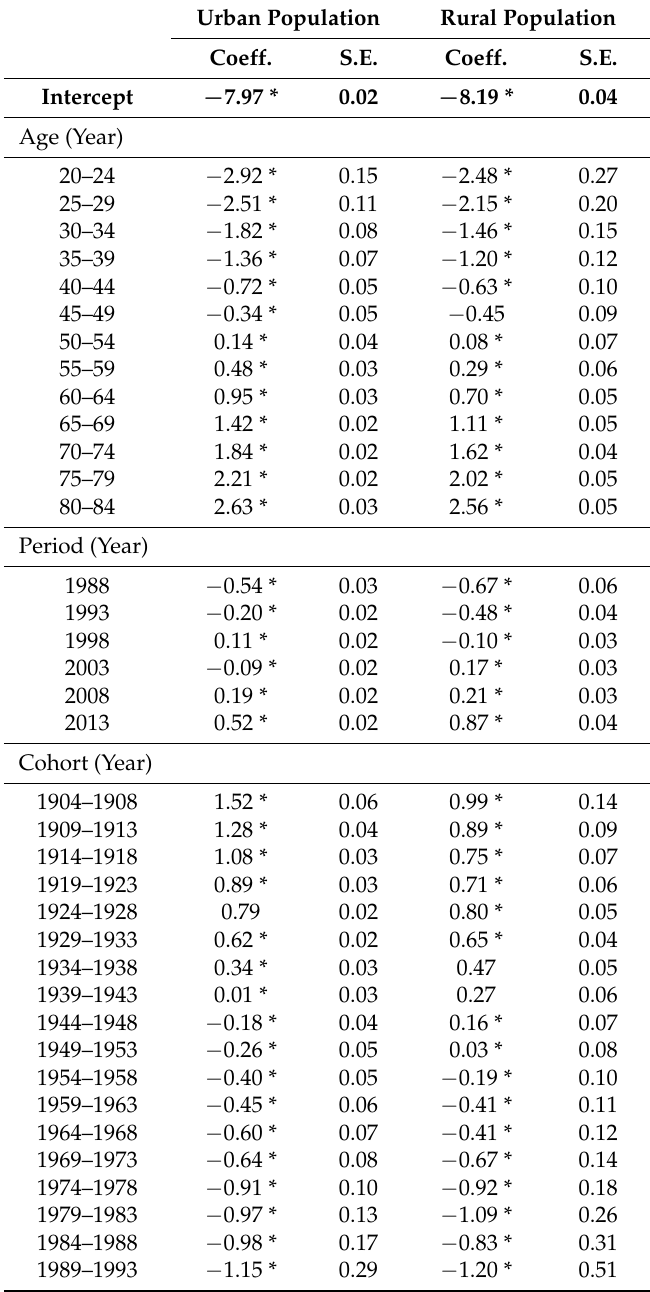
Table 2. Intrinsic estimates for IHD mortality rates in urban and rural Chinese population. Urban Population Rural Population Coeff. S.E. Coeff.